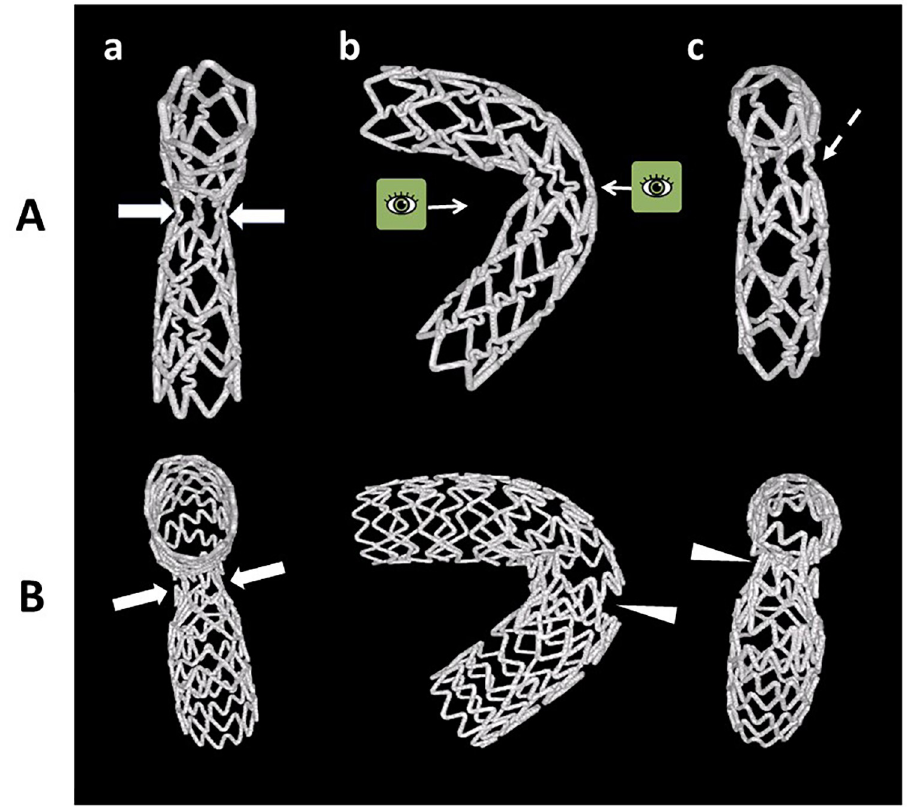
Fig 6. Micro-focus computed tomography images of the SB stents deployed from the MV (a: View from the inner side, b: Anterior—posterior view, c: View from the outer side). Experiments were performed using tube-slotted type stent (A) and coil type stent (B). There were restrictions of the stent expansions in both stents (A[a], B[a], arrows). The outer struts of the tube-slotted type stent were stretched (A[c], dotted arrow), whereas the coil type stent had wide opening between the coils at its outer side (B[b], [c], white triangles). Adapted from reference 7, Fig